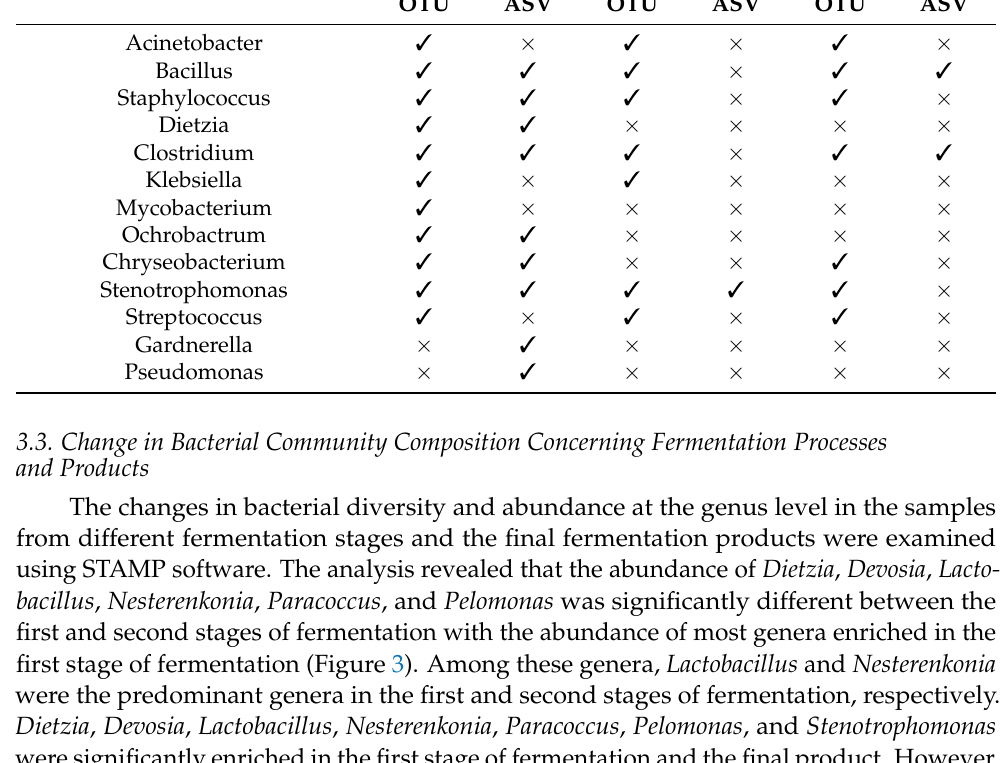
Table 2. Comparison of pathogenic genera identified using operational taxonomic unit-based and amplicon sequence variant-based clustering approaches and their association with fermentation processes. The symbol (cid:51) indicates the presence of the genus, whereas × represents the absence. 1st Stage 2nd Genus Names